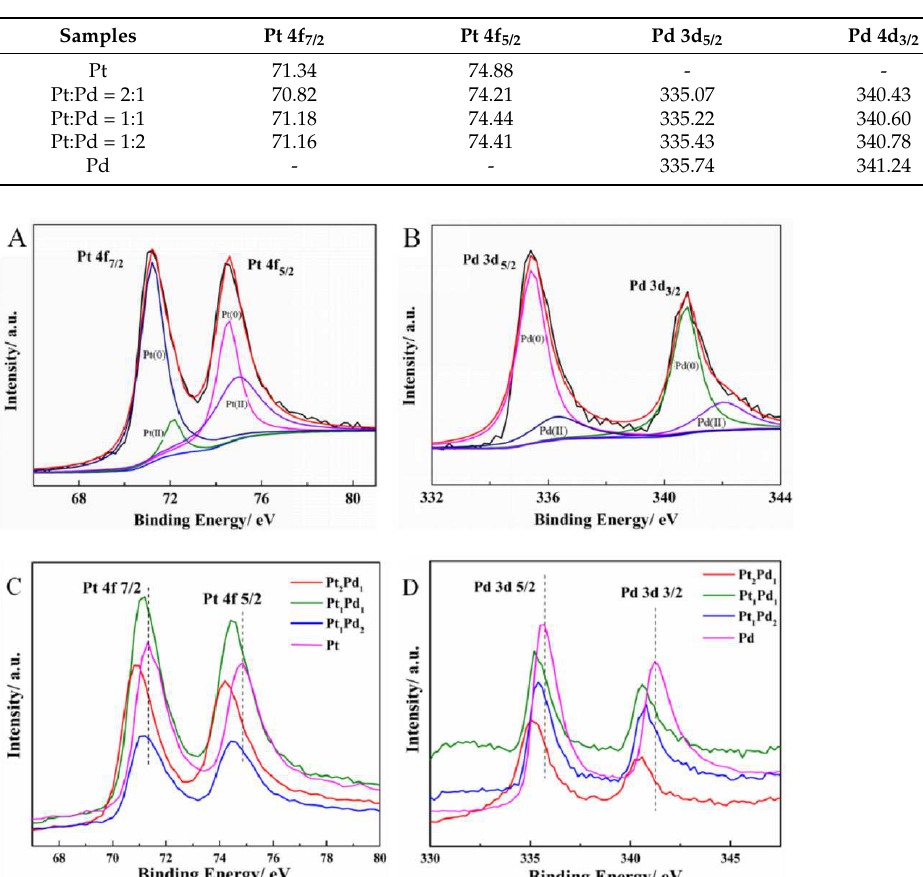
Table 1. Value of binding energies of Pt and Pd.